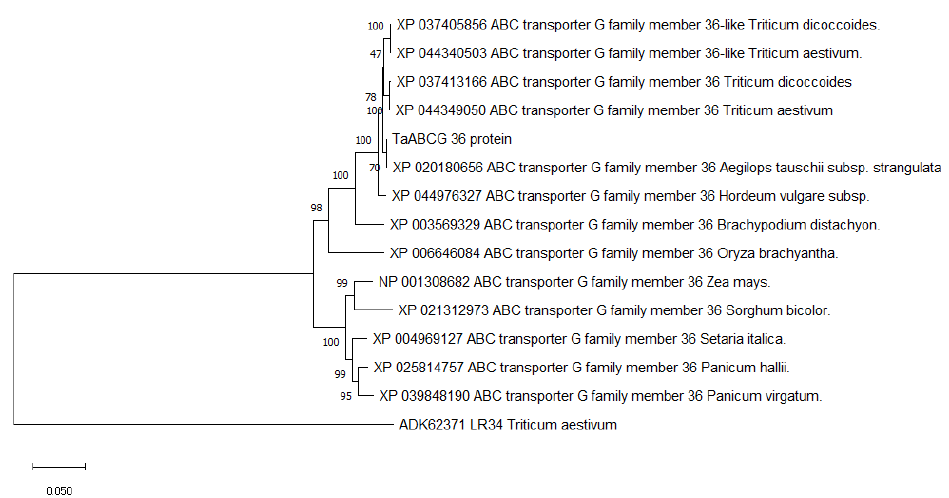
Figure 1. Phylogenetic tree based on the deduced amino acid sequences of TaABCG36 and those downloaded from NCBI.